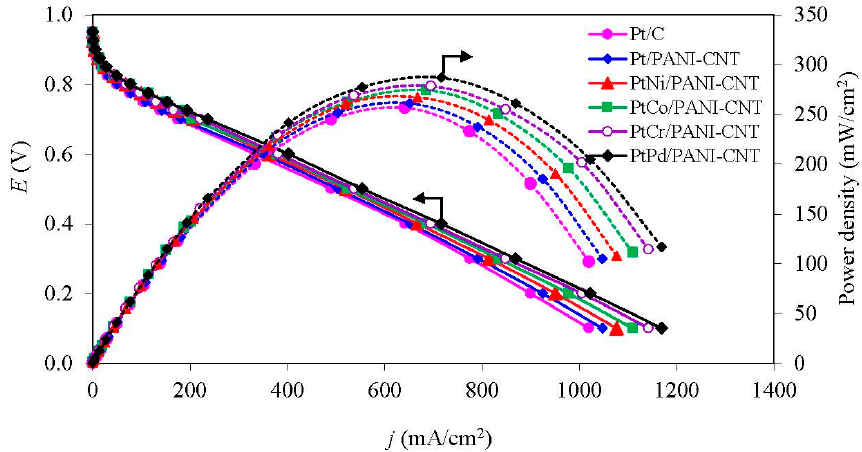
Figure 8. Representative of ORR activity of the Pt- and supported PtM catalysts in a single PEM fuel cell at 60 °C under a H 2 /O 2 environment and ambient pressure.